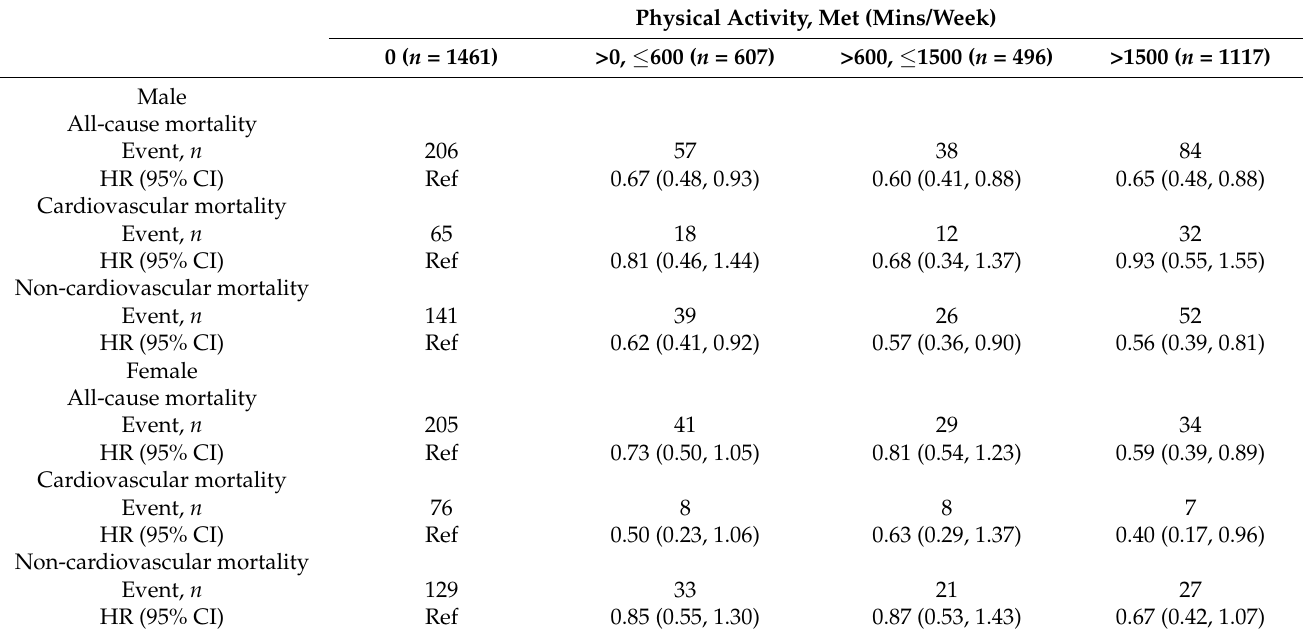
Table 2. Estimated hazard ratios from the Cox regression analyses of the association between mor- tality and the physical activity level in male and female.